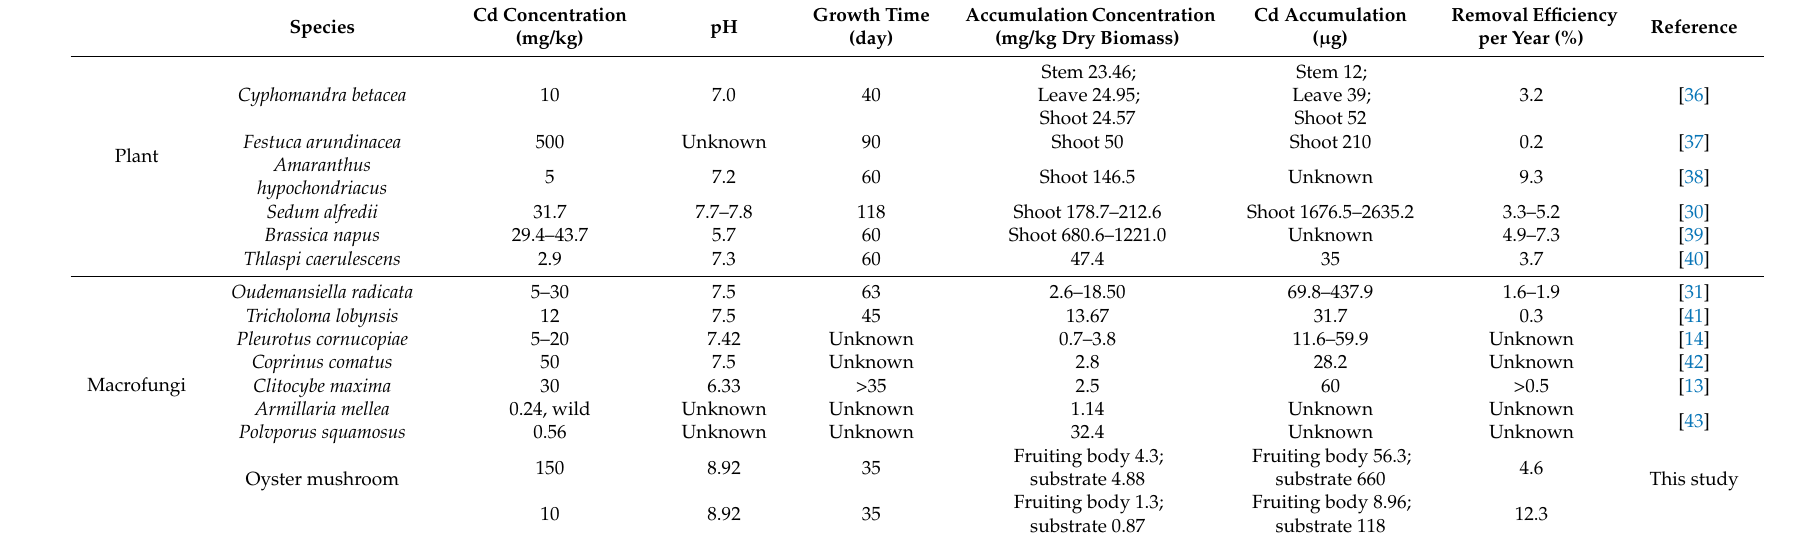
Table 2. Cadmium adsorption capacity of selective plants and mushroom strains reported in recent